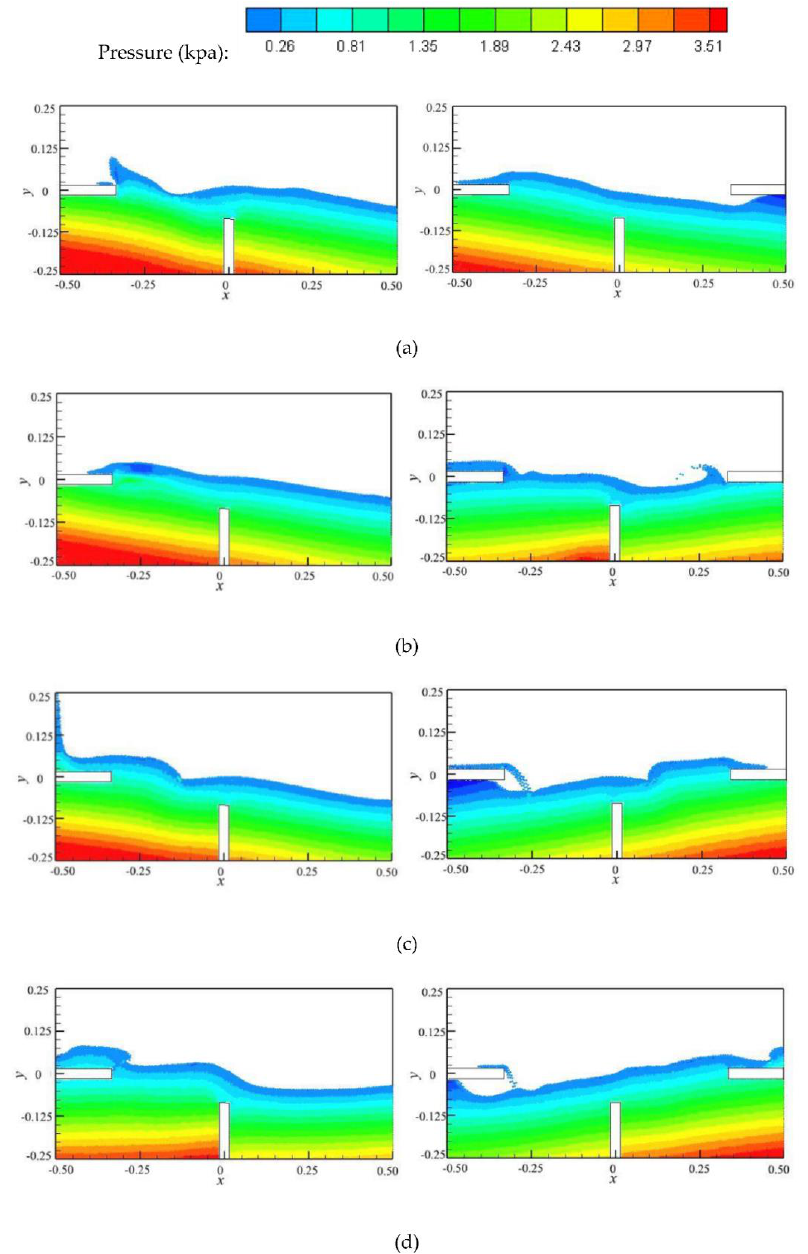
Figure 6. Particle snapshots and pressure contours of sloshing flow interactions with two complex baffles: ( a ) 0.0 T ; ( b ) T /6; ( c ) T /3; ( d ) T /2 (left: case Figure 5d; right: case Figure 5e).